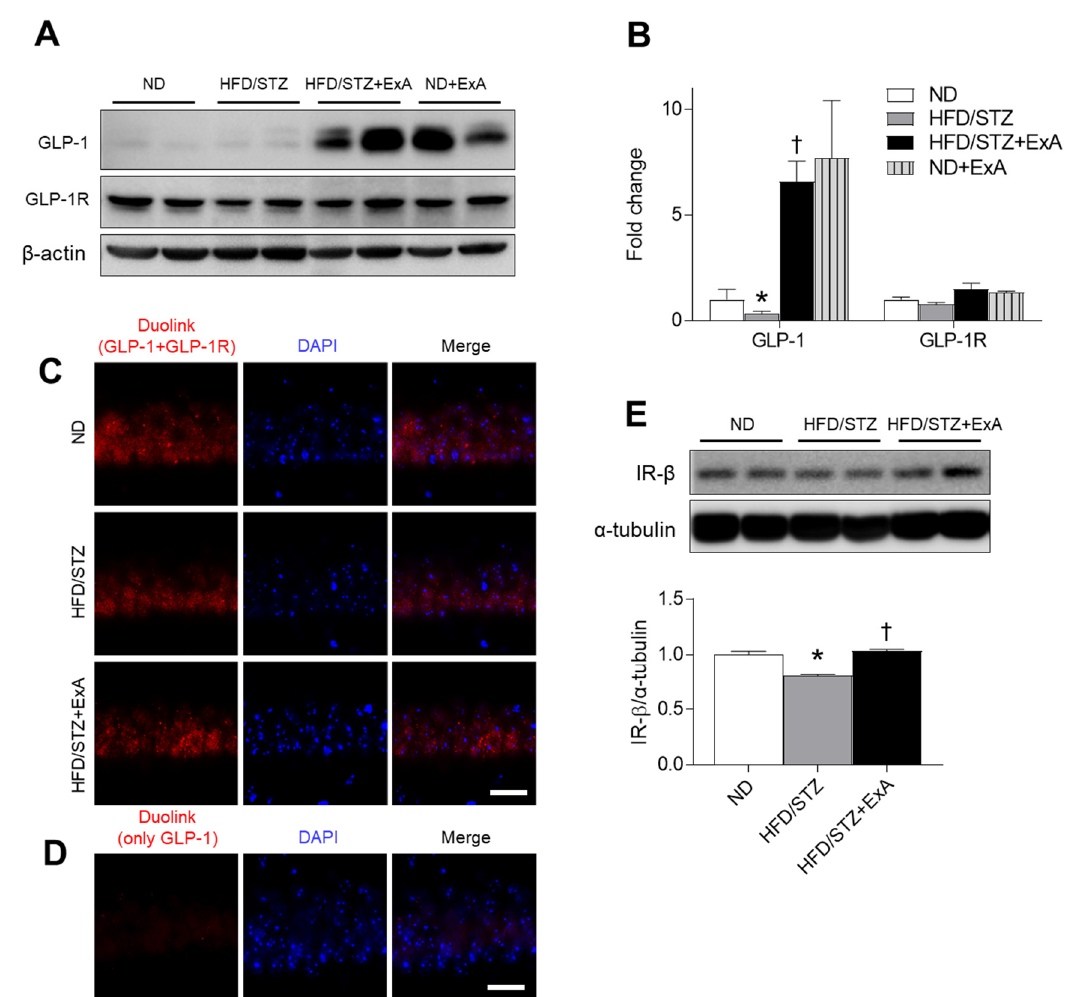
Figure 7. Effects of long-acting exendin-4-ABD-anti-FcRn affibody (ExA) on hippocampal GLP-1, GLP-1R, and IR- β expression levels in HFD/STZ mice. ( A,B ) Western blot analysis ( A ) and quantitative analysis ( B ) results showing GLP-1 and GLP-1R expression in the hippocampus. ( C ) Representative images of Duolink assay showing the interaction between GLP-1 and GLP-1R in the hippocampal CA1 region. Nuclei were stained with DAPI. ( D ) Negative control PLA with GLP-1 antibody only. Scale bar = 20 µ m. ( E ) Western blot and quantitative analysis results showing IR- β expression in the hippocampus. Both β -actin ( A ) and α -tubulin ( E ) were used as loading controls. Data (ˆ = 3–4 mice per group) are shown as the mean ± SEM. *: p < 0.05 vs. ND-fed mice, † : p < 0.05 vs. HFD / STZ mice.